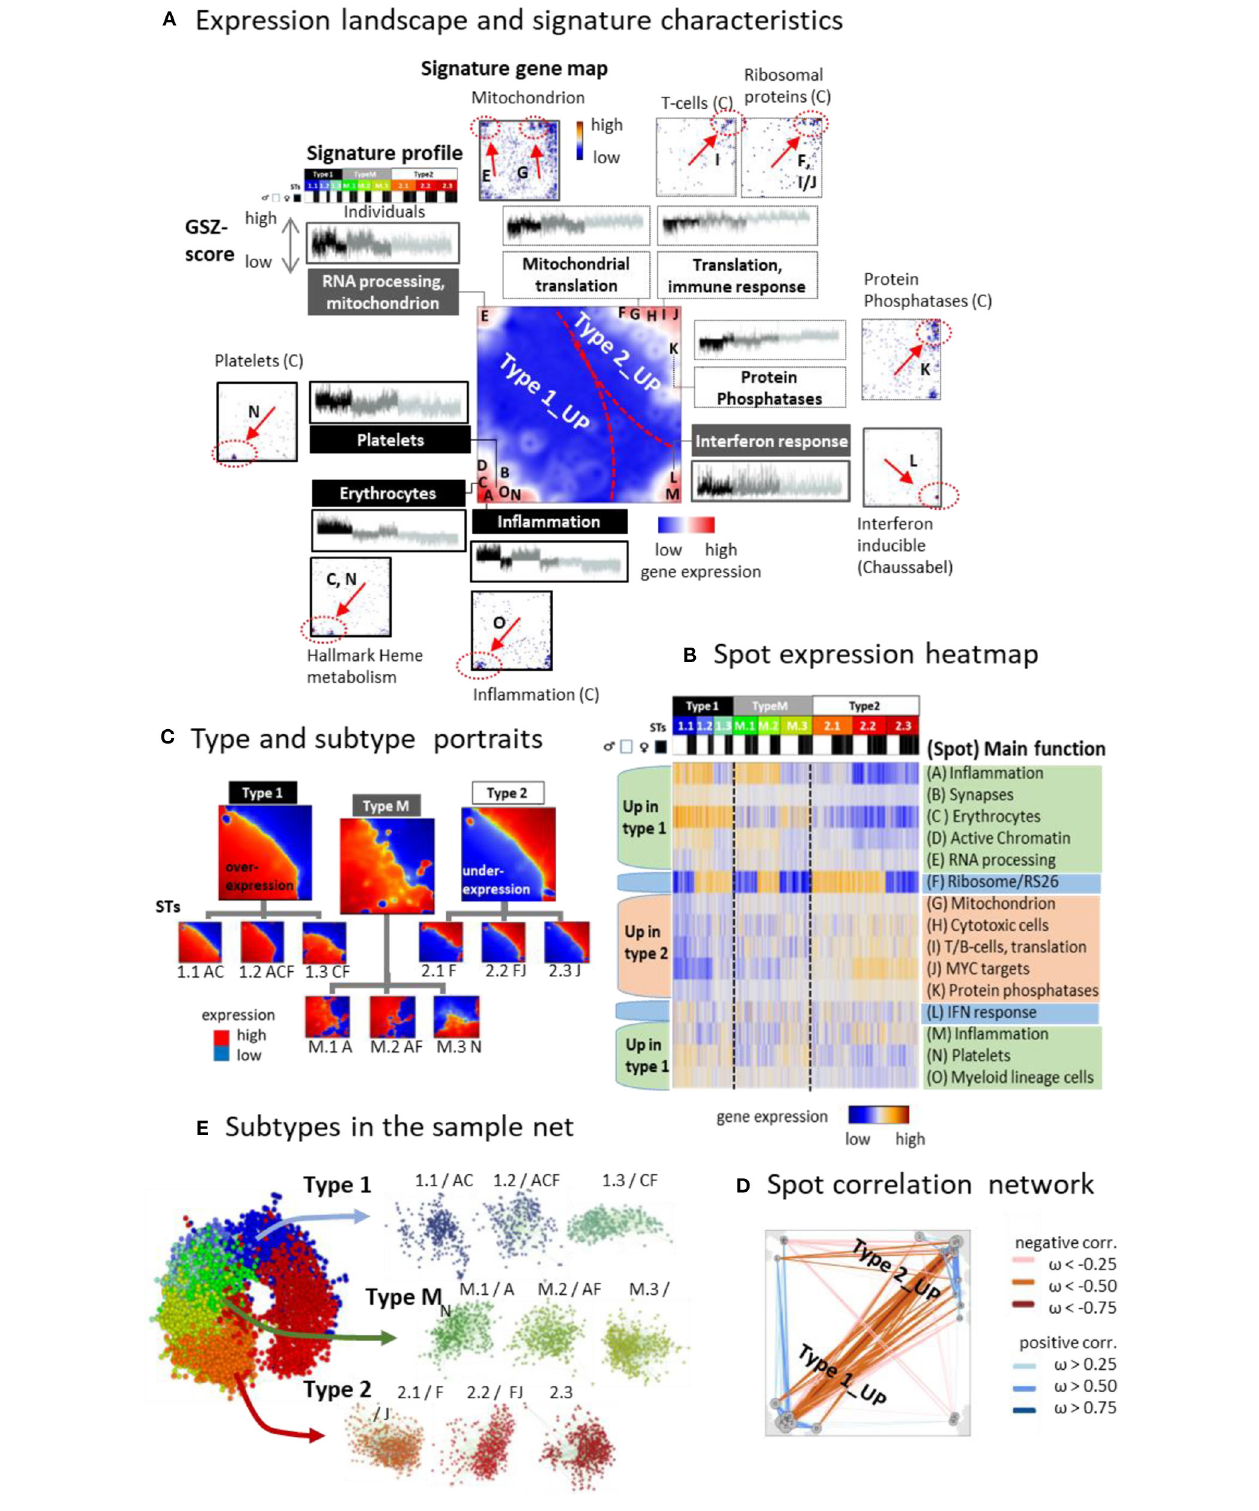
FIGURE 3 | The landscape of the blood transcriptome: (A) The spot overexpression summary map shown in the center of (A) provides an overview about spot-clusters of co-expressed genes labeled with capital letters A–M. The map divides into areas, which contain spots upregulated predominantly in type 1 and type 2